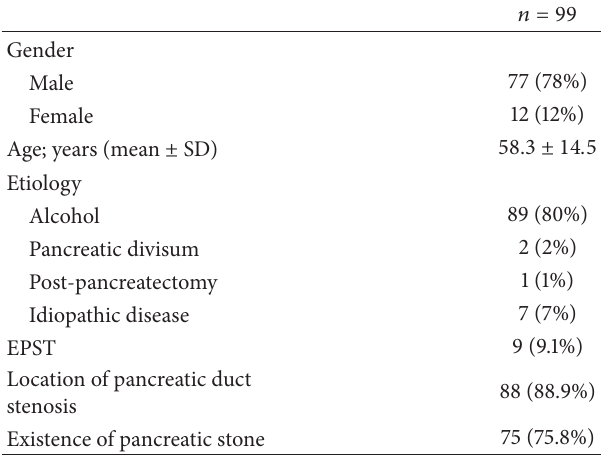
Table 1: Demographic characteristics of the study